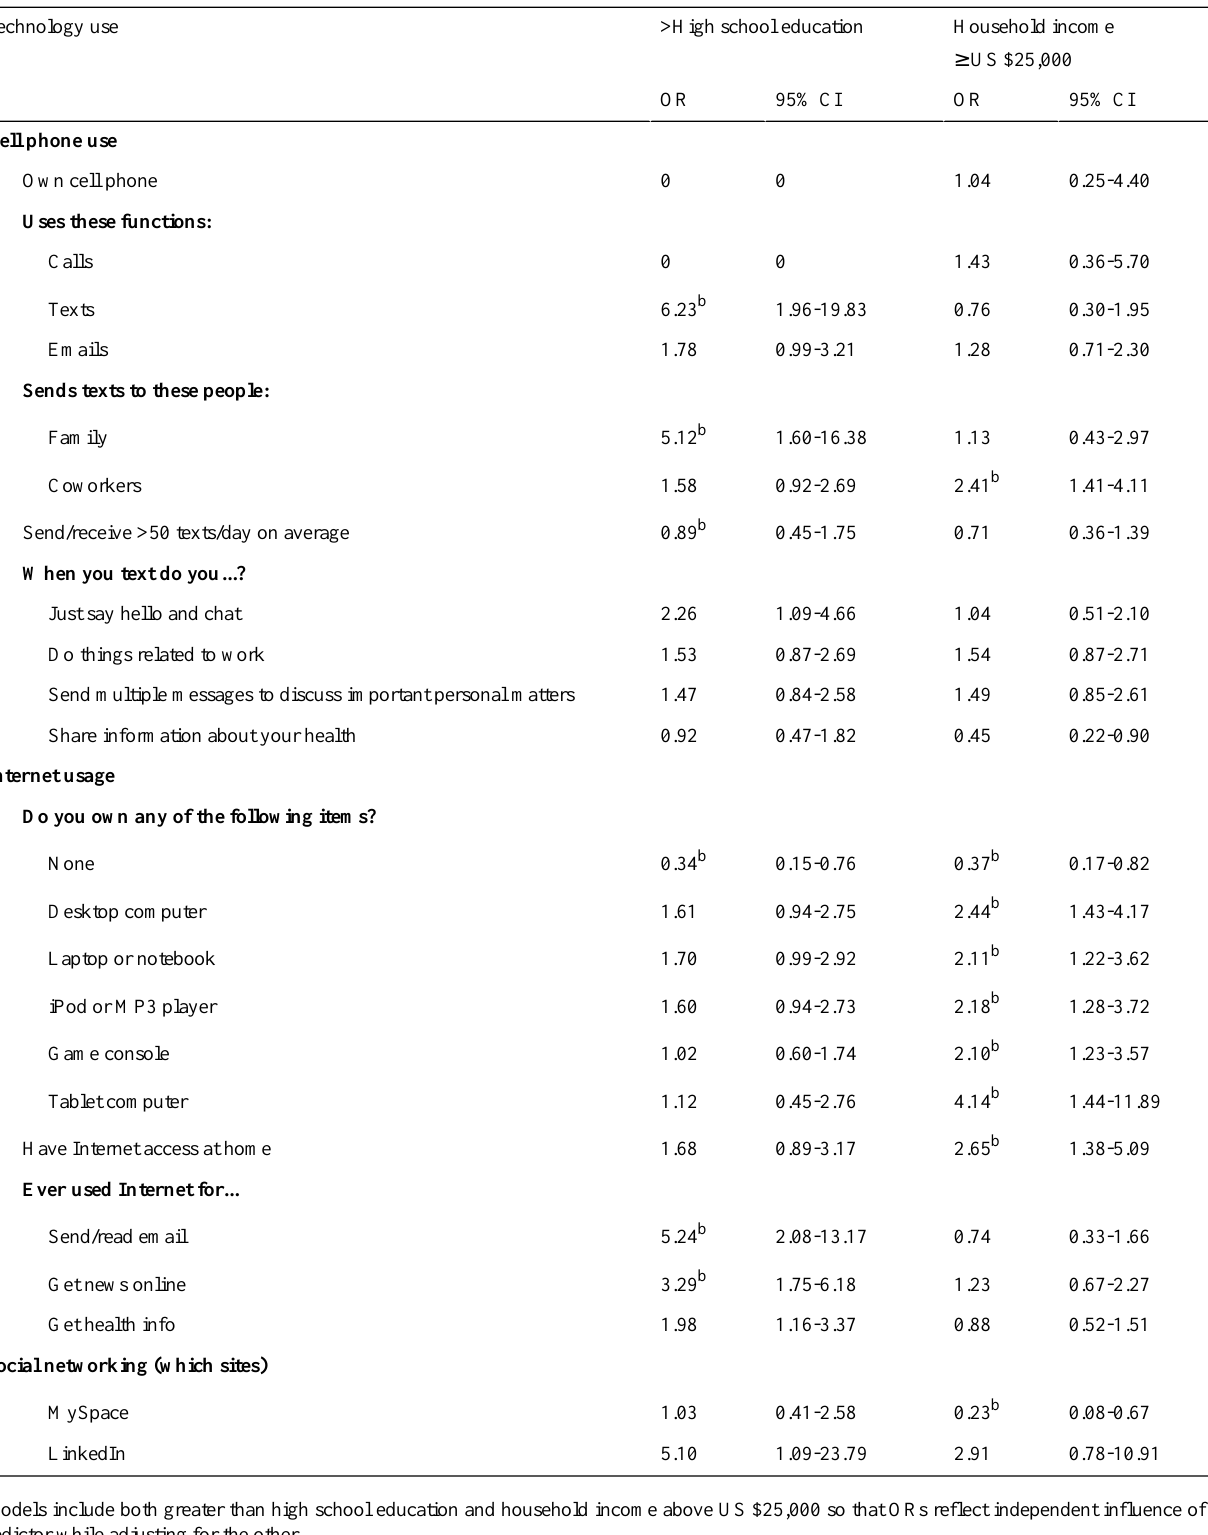
Table 3. Odds of reporting various cell phone, Internet, and social network usage for parents with more than a high school education or a household income above US $25,000.